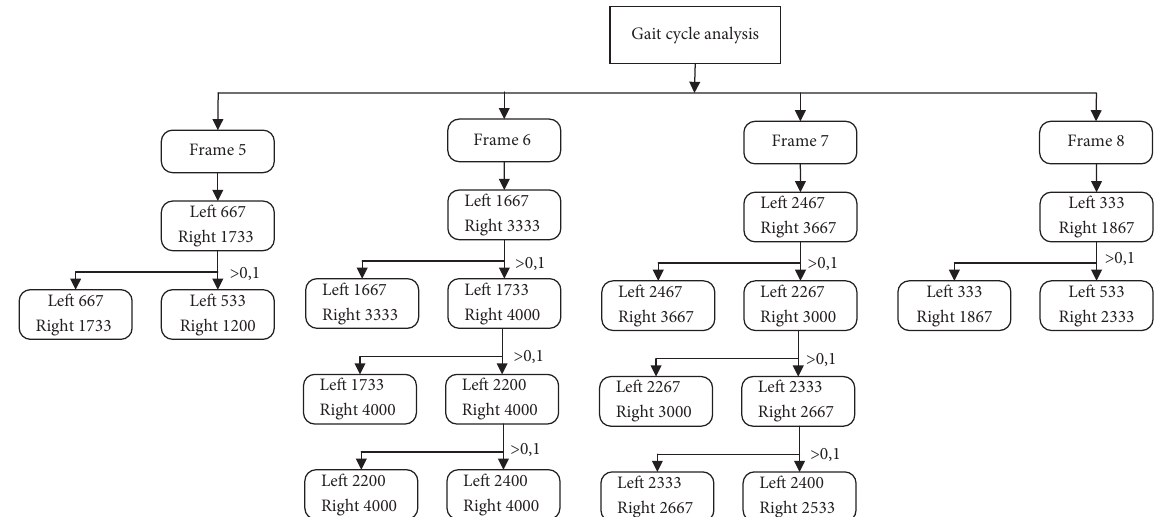
Figure 7: Decision tree scheme for the generation of assistive torque for the right hip.